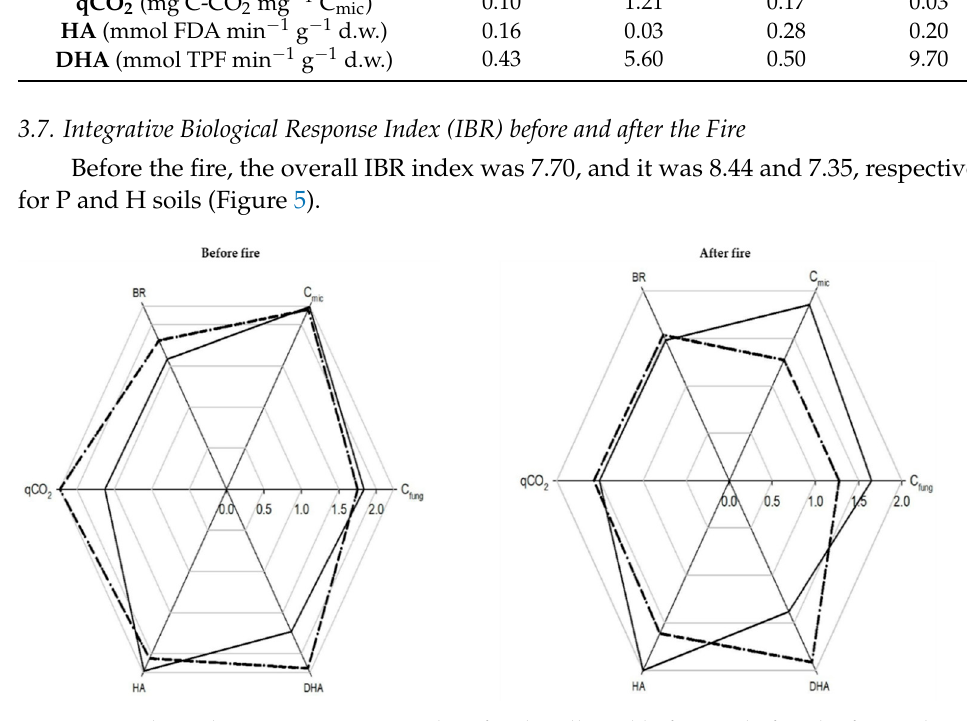
Table 4. Values of physico-chemical and biological parameters of the soils collected before and after the fire under herbaceous and pine specimens.